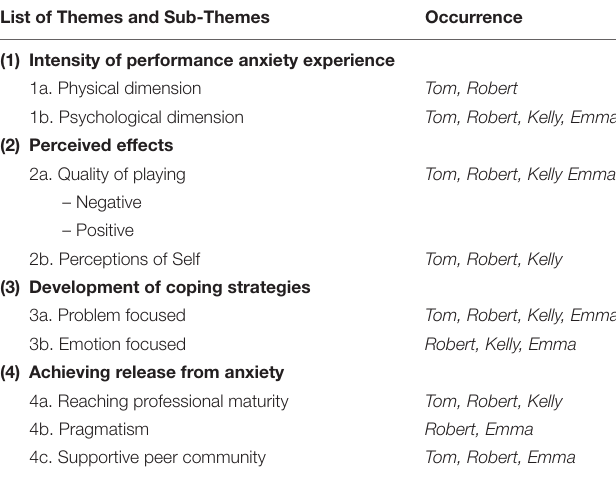
TABLE 1 | The analytic procedure. TABLE 2 | Emerging themes and sub-themes from the interviews 2